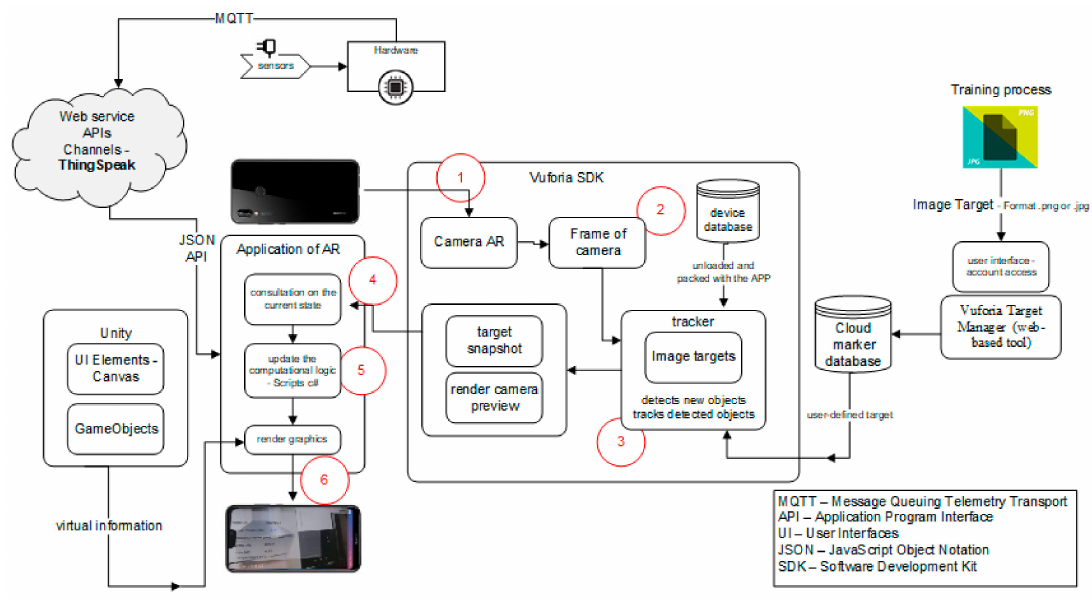
Figure 5. Application workflow.